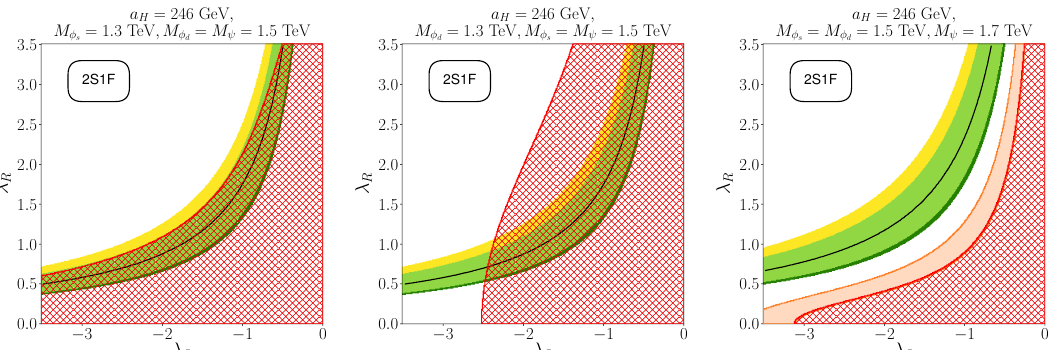
Figure 10. Results from Model 2S1F, scanning over the couplings of the new scalars and fermion to the left- and right-handed muon. The trilinear coupling which parametrises the mixing of the neutral BSM scalars is fixed to a = 246 GeV. Colours are the same as in figure 9. In these scenarios H the mass of either the scalar singlet φ , scalar doublet φ , or fermion ψ is displaced by 200 GeV s d s from the other BSM masses at 1500